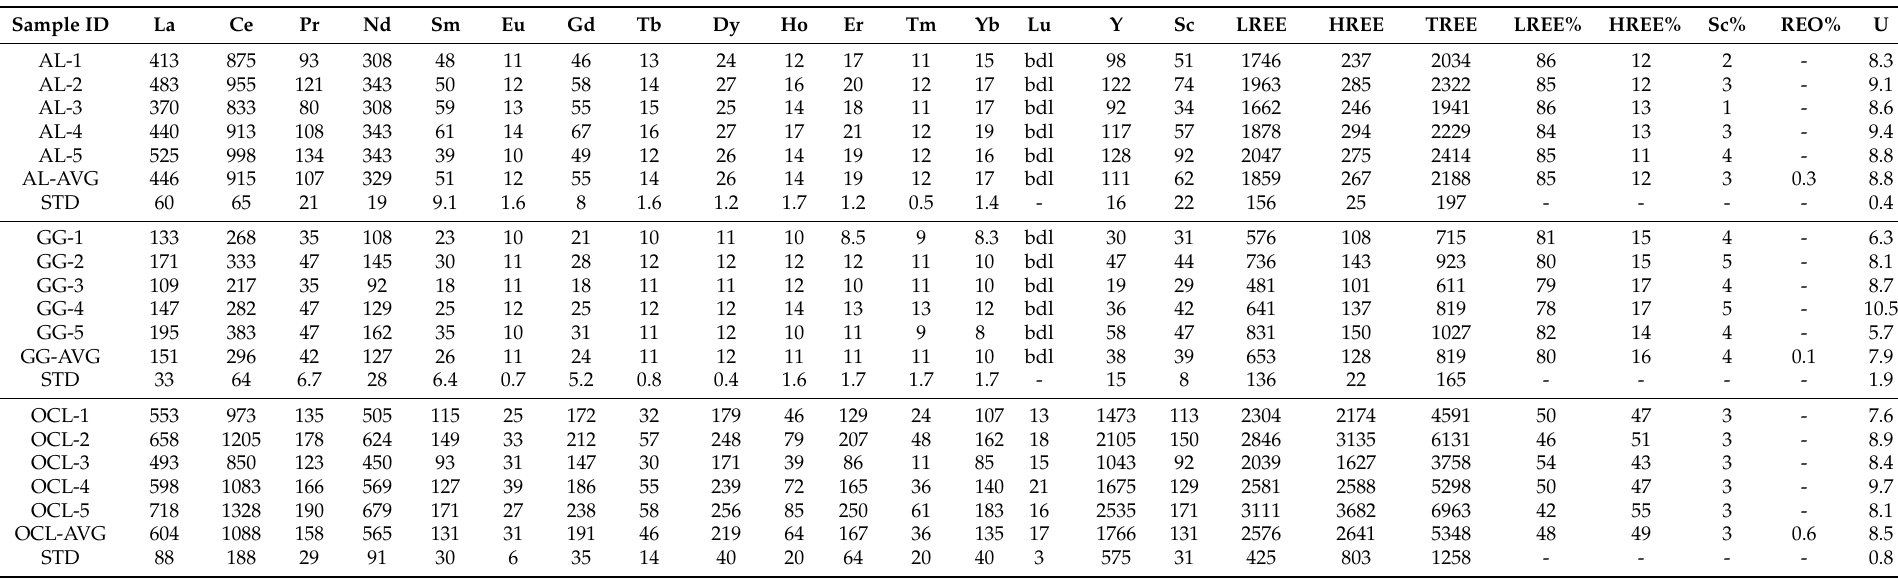
Table 1. REE and U concentrations (mg/kg) of alluvial (AL), gem gravel (GG), and organic-rich clay later (OCL) samples (bdl—below the detection limit, AVG—average, SD—standard